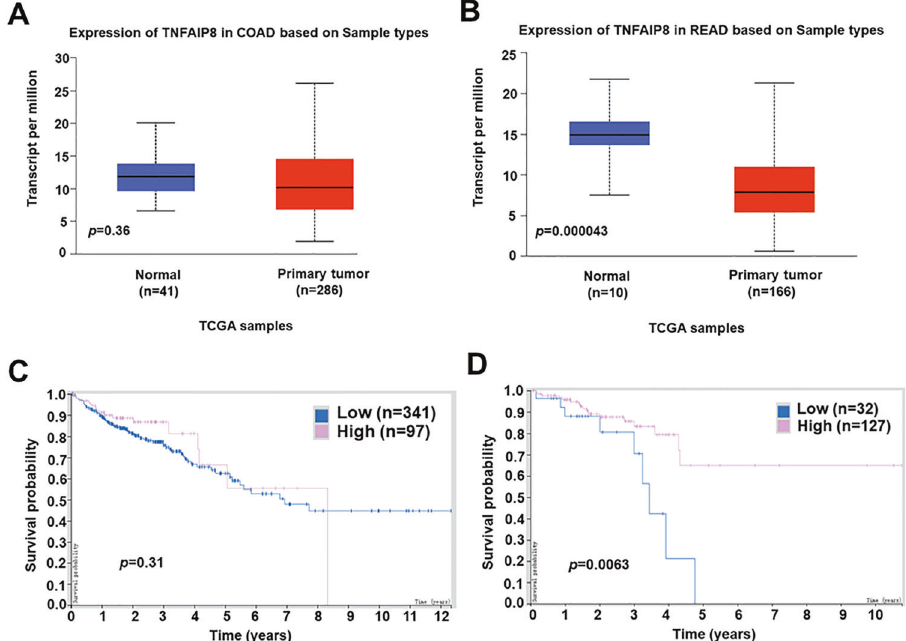
Fig. 7 TIPE gene expression is downregulated in human colorectal cancer and association of TIPE expression with patient survival. A Expression of TIPE in colon adenocarcinoma (COAD) compared to matched TCGA normal tissue. B Expression of TIPE in rectum adenocarcinoma (READ) compared to matched TCGA normal tissue. C , D Association of TIPE expression with patient survival in colon adenocarcinoma ( C ) or rectum adenocarcinoma ( D ) revealed through analyses of the human Protein Atlas database. (TISCH). There are eight CRC datasets in total at this time, including found the association of TIPE low expression with worsened fi ve human CRC datasets (Supplemental Fig. 7A). We found that patient survival in READ, but not in COAD (Fig. 7C, D). We next only CRC_GSE146771_Smartseq2 applied FACS to isolate CD45 + further evaluated the translational relevance of our fi ndings by analyzing TIPE expression with the Tumor Immune Single- cell Hub (immune fractions) and CD45 - (non-immune fractions), so this